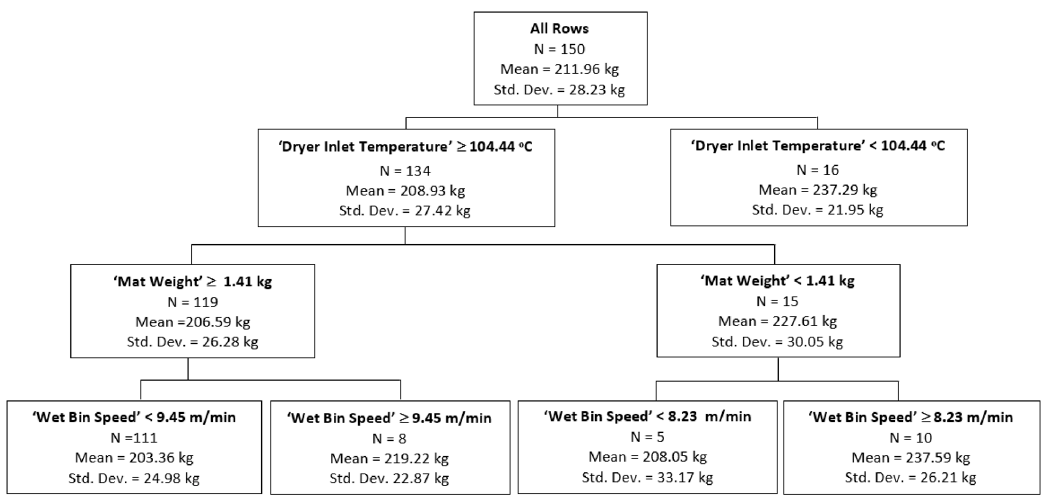
Figure 2. Regression tree for OSB ultimate static load derived from boosted tree and random forest models.